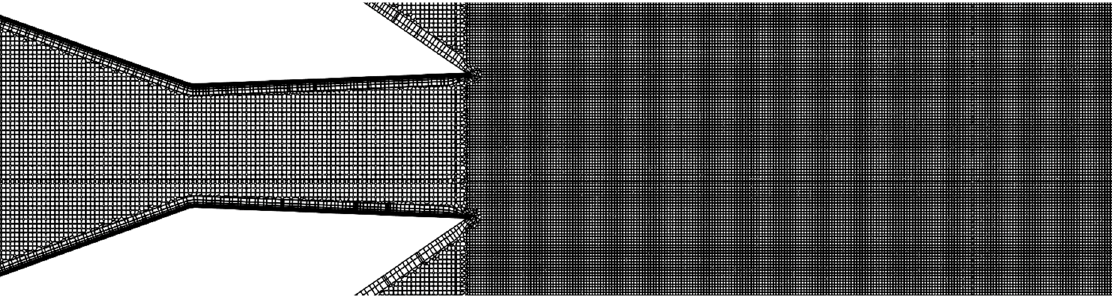
Figure 16. LES grid: Zoomed ‐ in view near nozzle